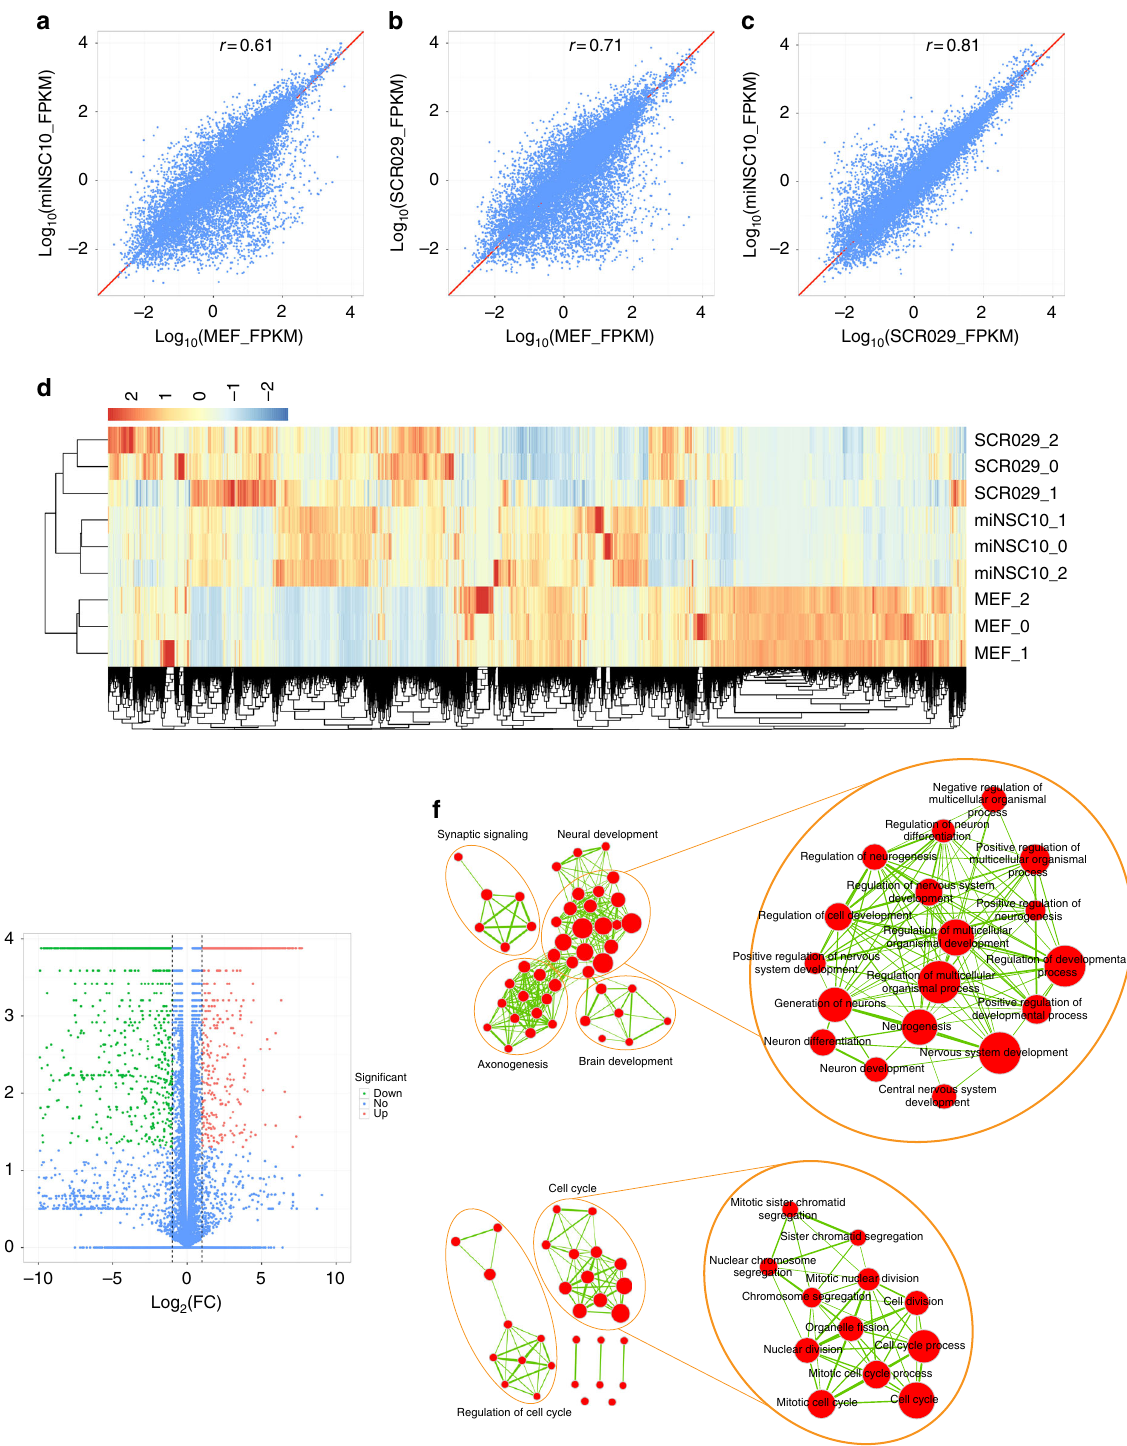
Fig. 3 Global gene expression pro fi les of iNSCs, control NSCs, and MEFs. a – c Pairwise scatter plot analysis of the global gene expression pro fi les of miNSC10, SCR029, and MEF cells. The transcriptome of each cell type was pro fi led by RNA-seq analysis. Gene expression levels (FPKM) are depicted in log 10 scale. Pearson ’ s correlation coef fi cients ( r ) are indicated. d Heat map of the z -transformed gene expression values in miNSC10, SCR029, and MEF cells. miNSC10 and SCR029 cells are classi fi ed into the same hierarchical cluster. e Volcano plot (signi fi cance vs. fold change) of signi fi cantly altered genes (fold change ≥ 2 and FDR < 0.05) between miNSC10 and MEF cells. f Gene ontology (GO) enrichment analysis of the upregulated genes between miNSC10 and MEF cells. The upregulated genes were analyzed for GO term enrichment by gene-set enrichment analysis (GSEA). The result was visualized on a network of gene sets (nodes) connected by their similarity (edges). Node size represents the gene-set size and edge thickness represents the degree of overlap between two gene sets. Depicted are the two major groups of enriched gene